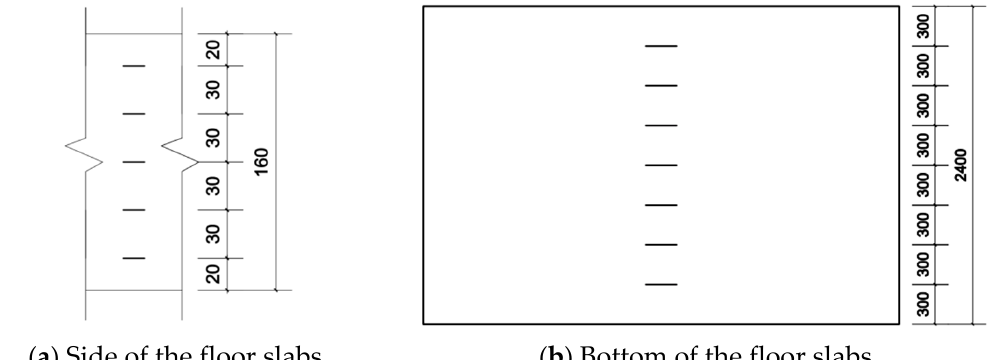
Figure 10. Layout of measuring points of concrete strain gauge (unit: mm).